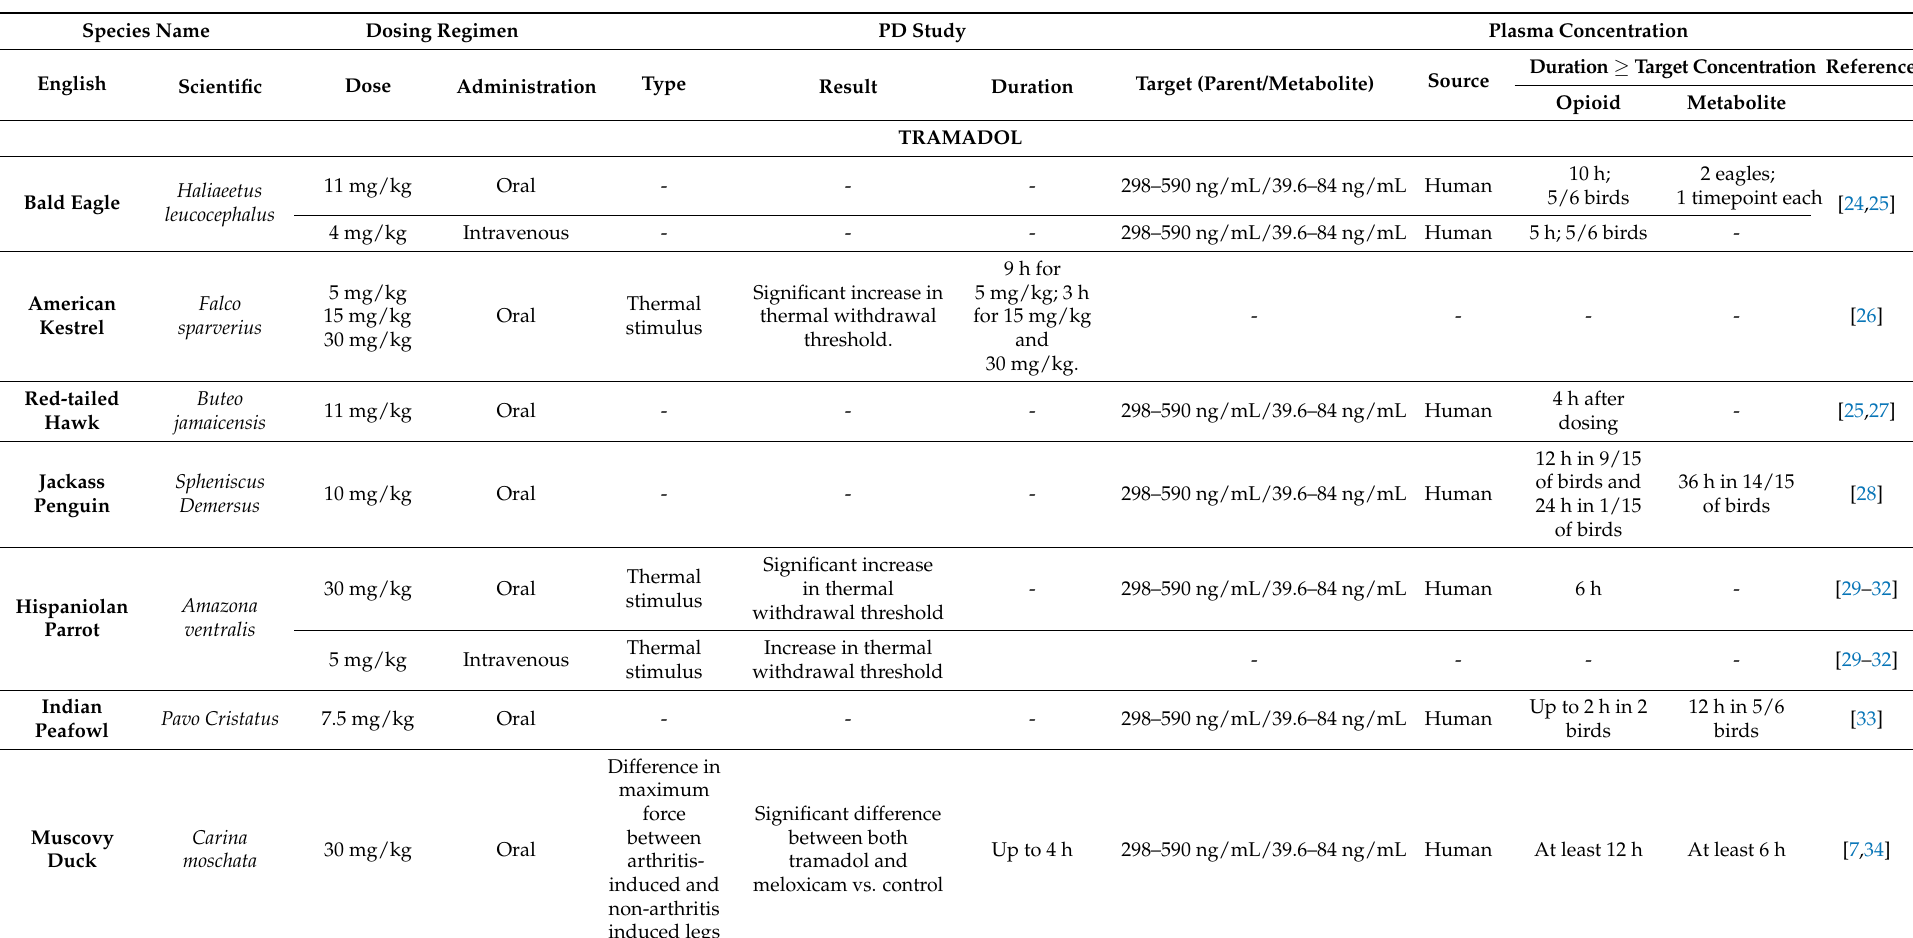
Table 3. Efficacy of selected opioids based on pharmacodynamics studies and plasma